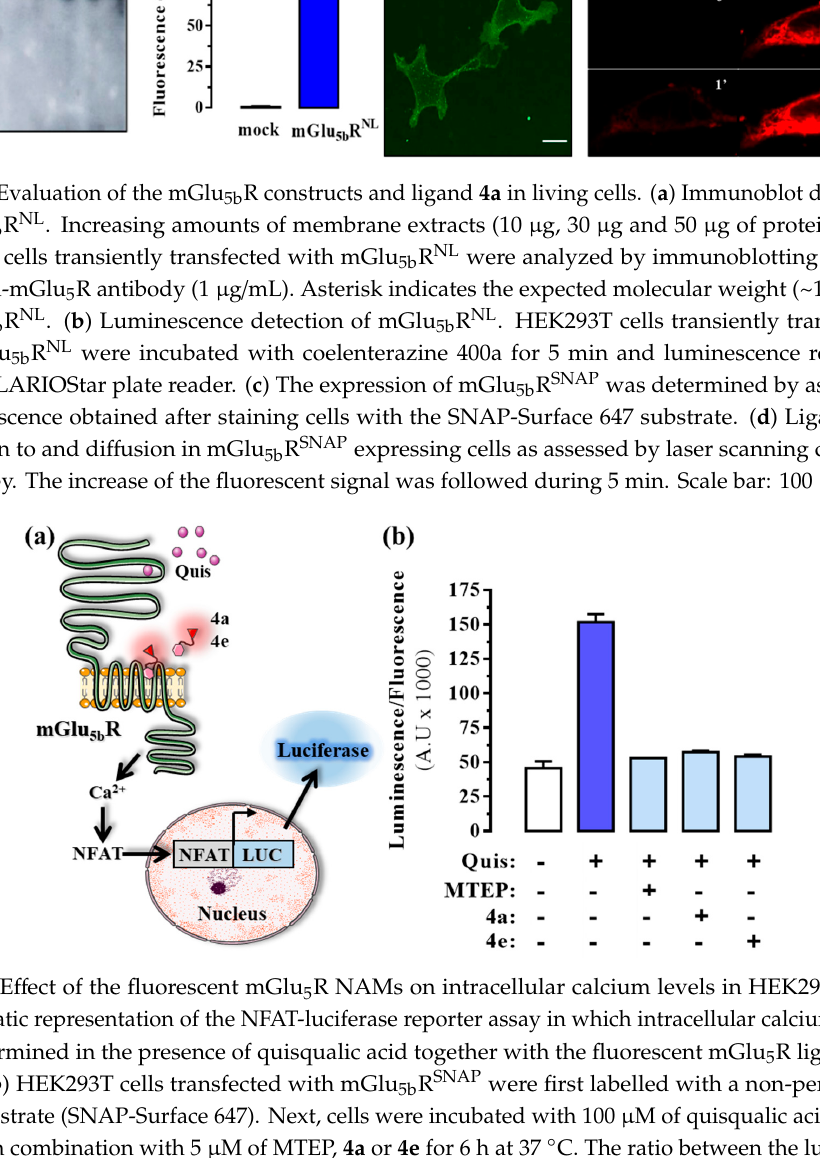
Figure 5. Effect of the fluorescent mGlu 5 R NAMs on intracellular calcium levels in HEK293T cells. ( a ) Schematic representation of the NFAT-luciferase reporter assay in which intracellular calcium levels were determined in the presence of quisqualic acid together with the fluorescent mGlu 5 R ligands 4a and 4e . ( b ) HEK293T cells transfected with mGlu 5b R SNAP were first labelled with a non-permeable SNAP substrate (SNAP-Surface 647). Next, cells were incubated with 100 µ M of quisqualic acid (Quis) alone or in combination with 5 µ M of MTEP, 4a or 4e for 6 h at 37 ◦ C. The ratio between the luciferase activity (535 nm) and the fluorescence intensity of the receptor (647 nm) was calculated to normalize the signal by the number of receptor-expressing cells. Data are the mean ± SEM of three independent experiments performed in triplicate. ** p < 0.01, one-way ANOVA followed by Dunnett’s post-hoc test. Figure designed using image templates from